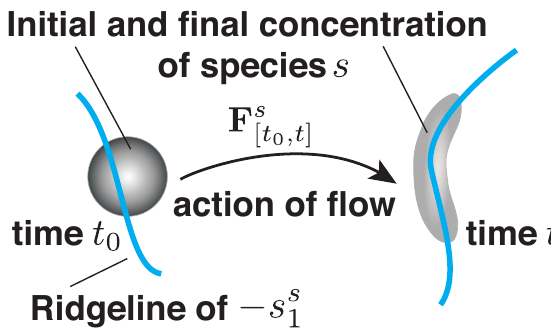
s s , on a small 1 −